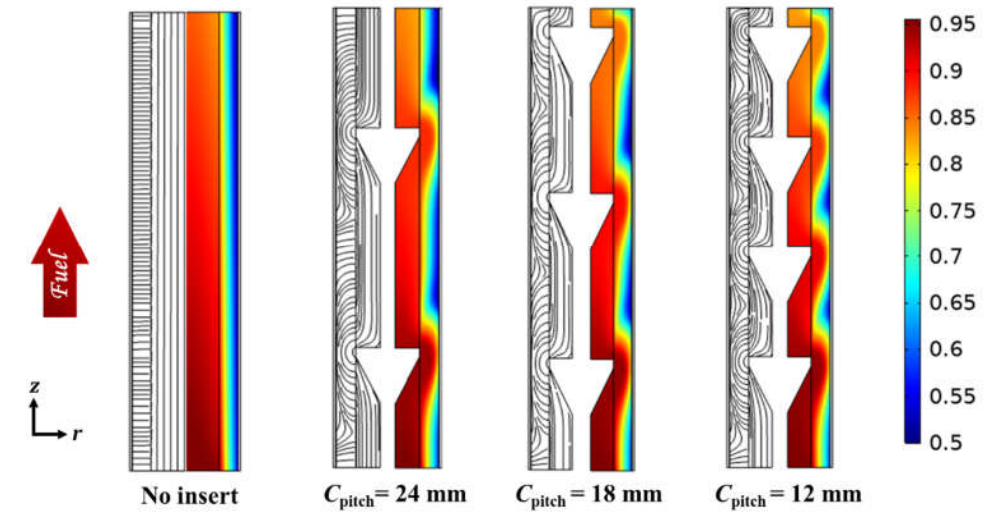
Figure 9. The streamlines and CO mole fractions of the micro-tubular SOFCs, without an insert and with cone-inserts of different pitches.